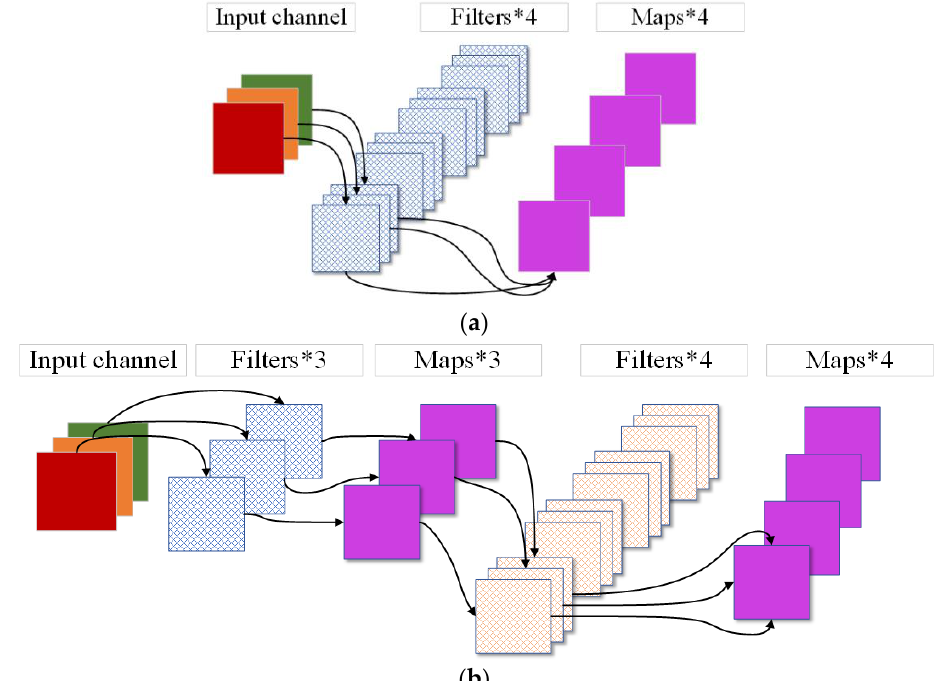
Figure 4. Comparison between standard convolution ( a ) and depthwise separable convolution ( b ). Here Filters*3 indicates that there are three Filters, and so on.